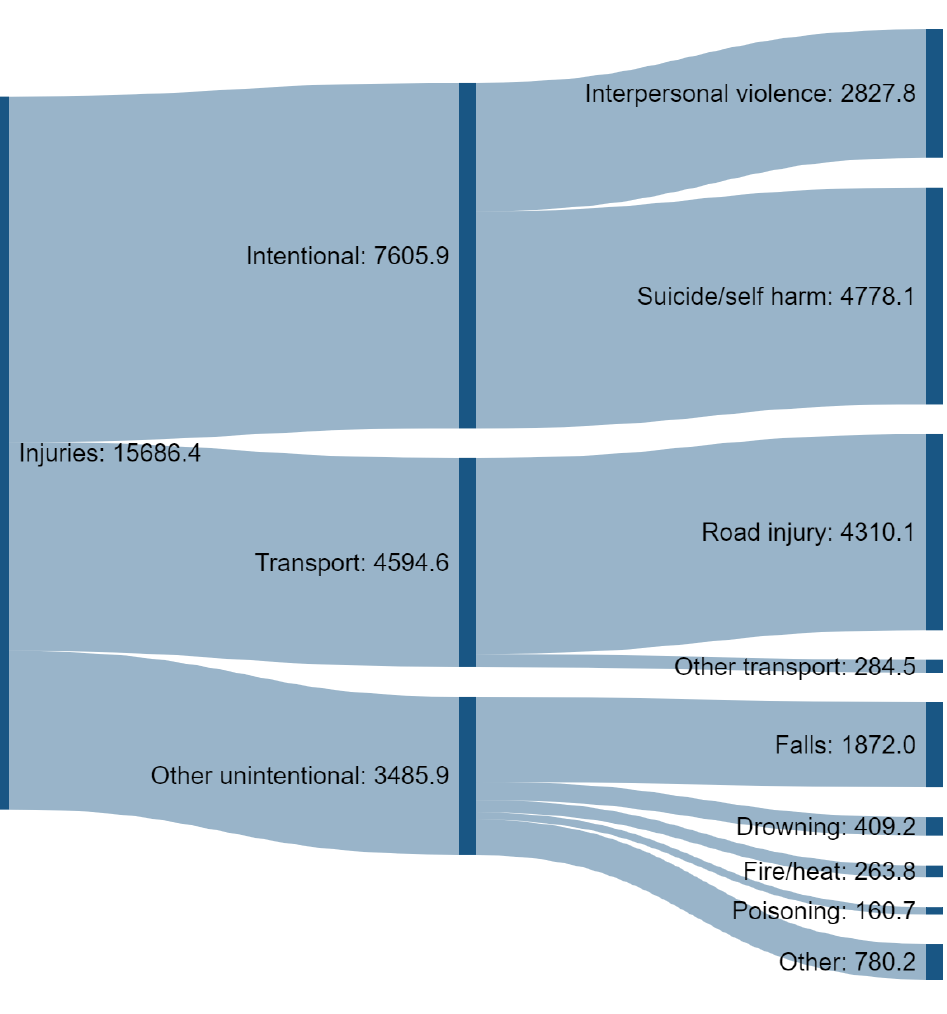
Figure 1. Global Disability Adjusted Life Years (DALYs ’000) lost due to alcohol-attributable injuries, 2019. Data source: Institute for Health Metrics and Evaluation [1].